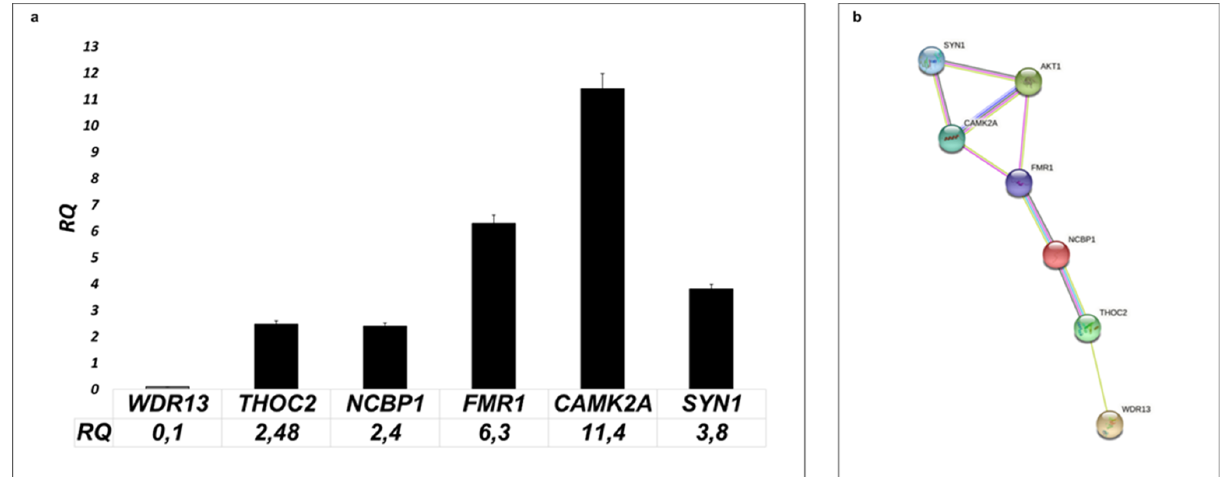
Figure 2. ( a ) Analysis of expression of selected synaptic genes in patient's fibroblast. RQ presented fold change of genes in affected patients normalized to the expression of genes in unaffected control (set to 1). ( b ) String analysis of protein encoding by analyzing patients' cells genes. Strings indicate both functional and physical protein associations and gene co-expression (https://string-db.org/, accessed on 20 October.2021).